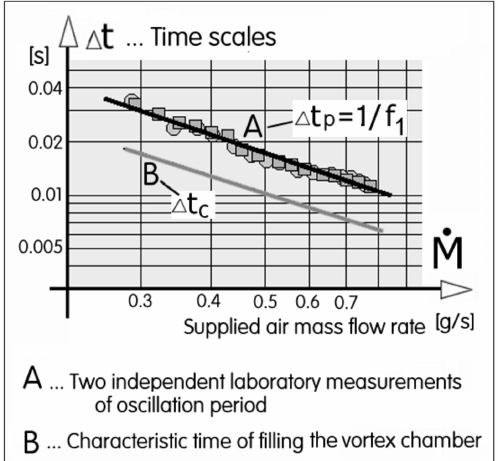
Figure 15. In the logarithmic co-ordinates the two characteristic time periods, Equation (3) and (4), are plotted as parallel straight lines A and